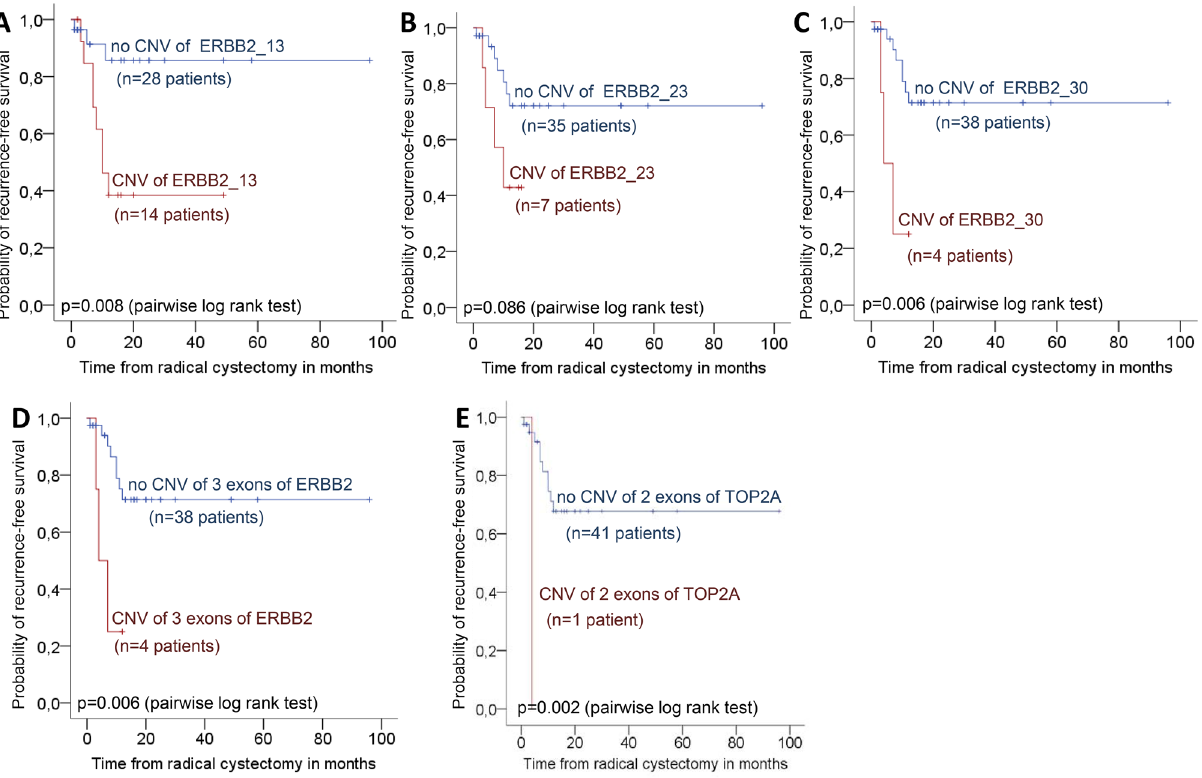
Figure 2. Kaplan–Meier plots of recurrence-free survival stratified by CNV in ERBB2 ( A – D ) and TOP2A ( E ) in 43 UCB patients treated with RC. Top curves (in blue) show UCB patients with no CNV (no genomic aberrations), and bottom curves (in red) show patients with CNV comprising DNA gains in the 13th exon (ERBB2_13. A ), 23th exon (ERBB2_23, B ), 30th exon (ERBB2_30, C ) and all 3 exons patients of ERBB2 ( D ), as well as in both exons of TOP2A ( E